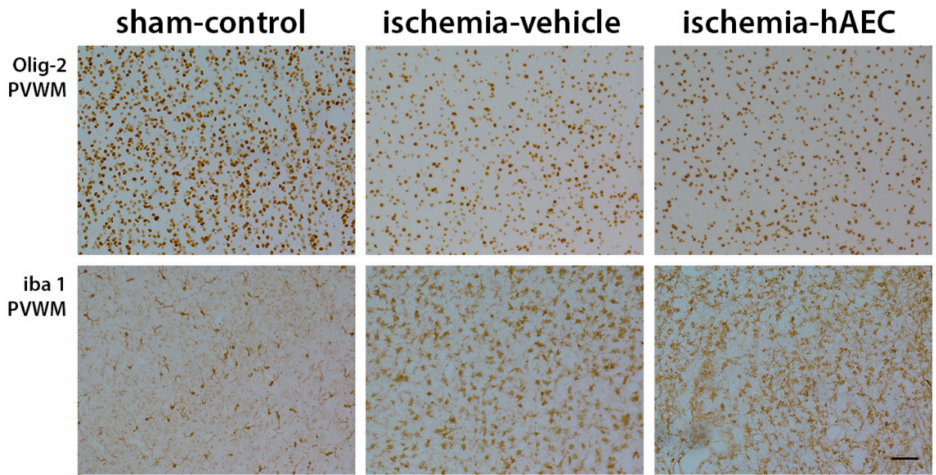
Figure 5. Photomicrographs showing representative Olig-2- and Iba1-labelled images in the periven- tricular white matter in the sham control, ischemia-vehicle and ischemia-hAEC groups. Scale bar is 50 µ